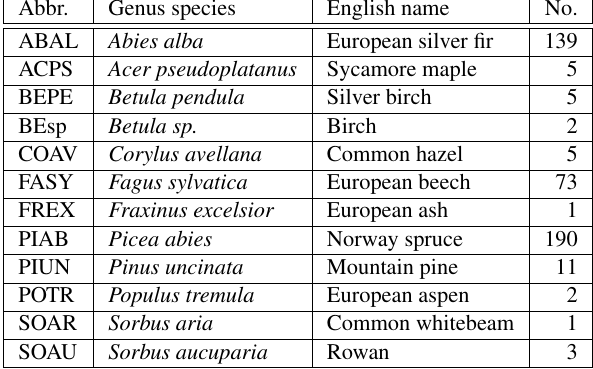
Table 2: Abbreviation, full name and number of tree crowns per